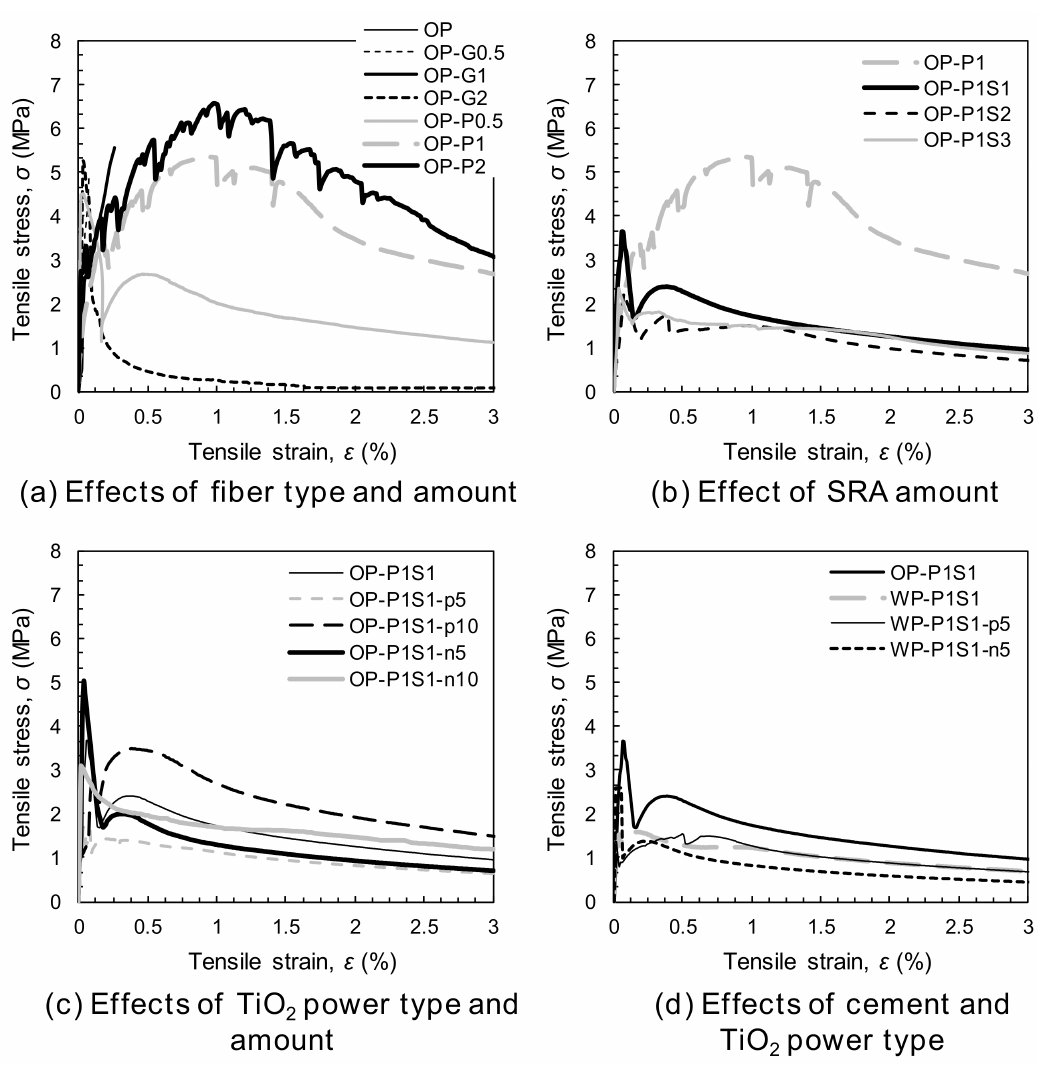
Figure 8. Summary of the tensile stress and strain curves: ( a ) the e ff ects of the fiber type and amount, ( b ) the e ff ect of the SRA amount, ( c ) the e ff ects of the TiO 2 powder type and amount, and ( d ) the e ff ects of the cement and the TiO 2 powder type.